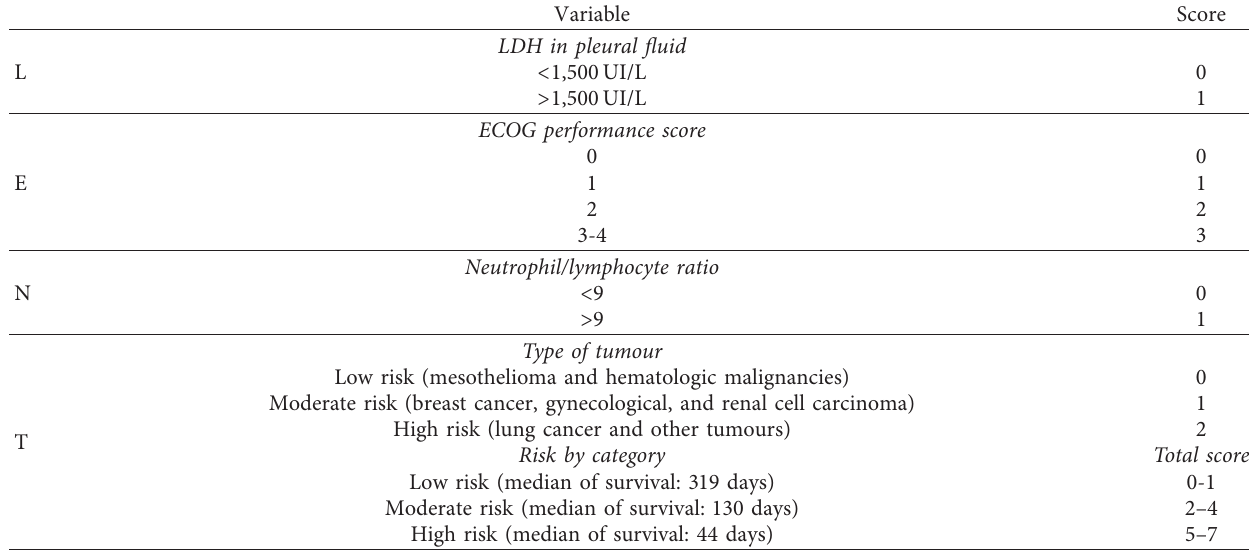
Table 1: A prognostic score for malignant pleural effusions (LENT)